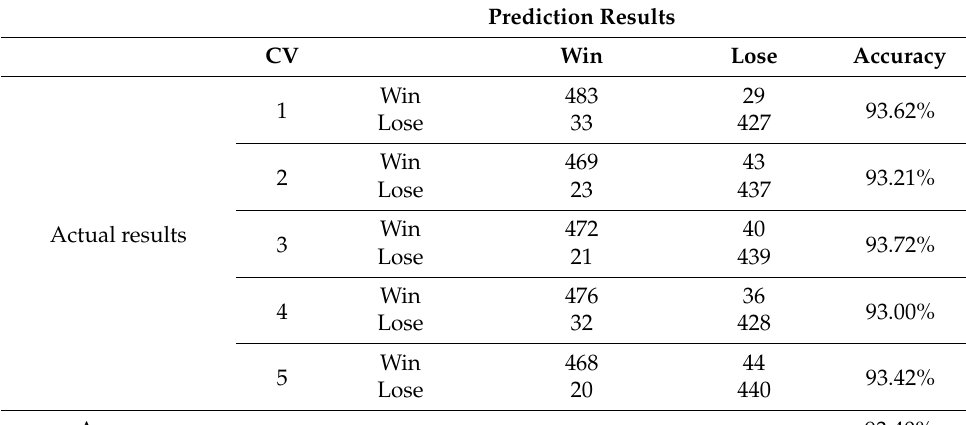
Table 11. Confusion matrix of 1DCNN (dataset 2).